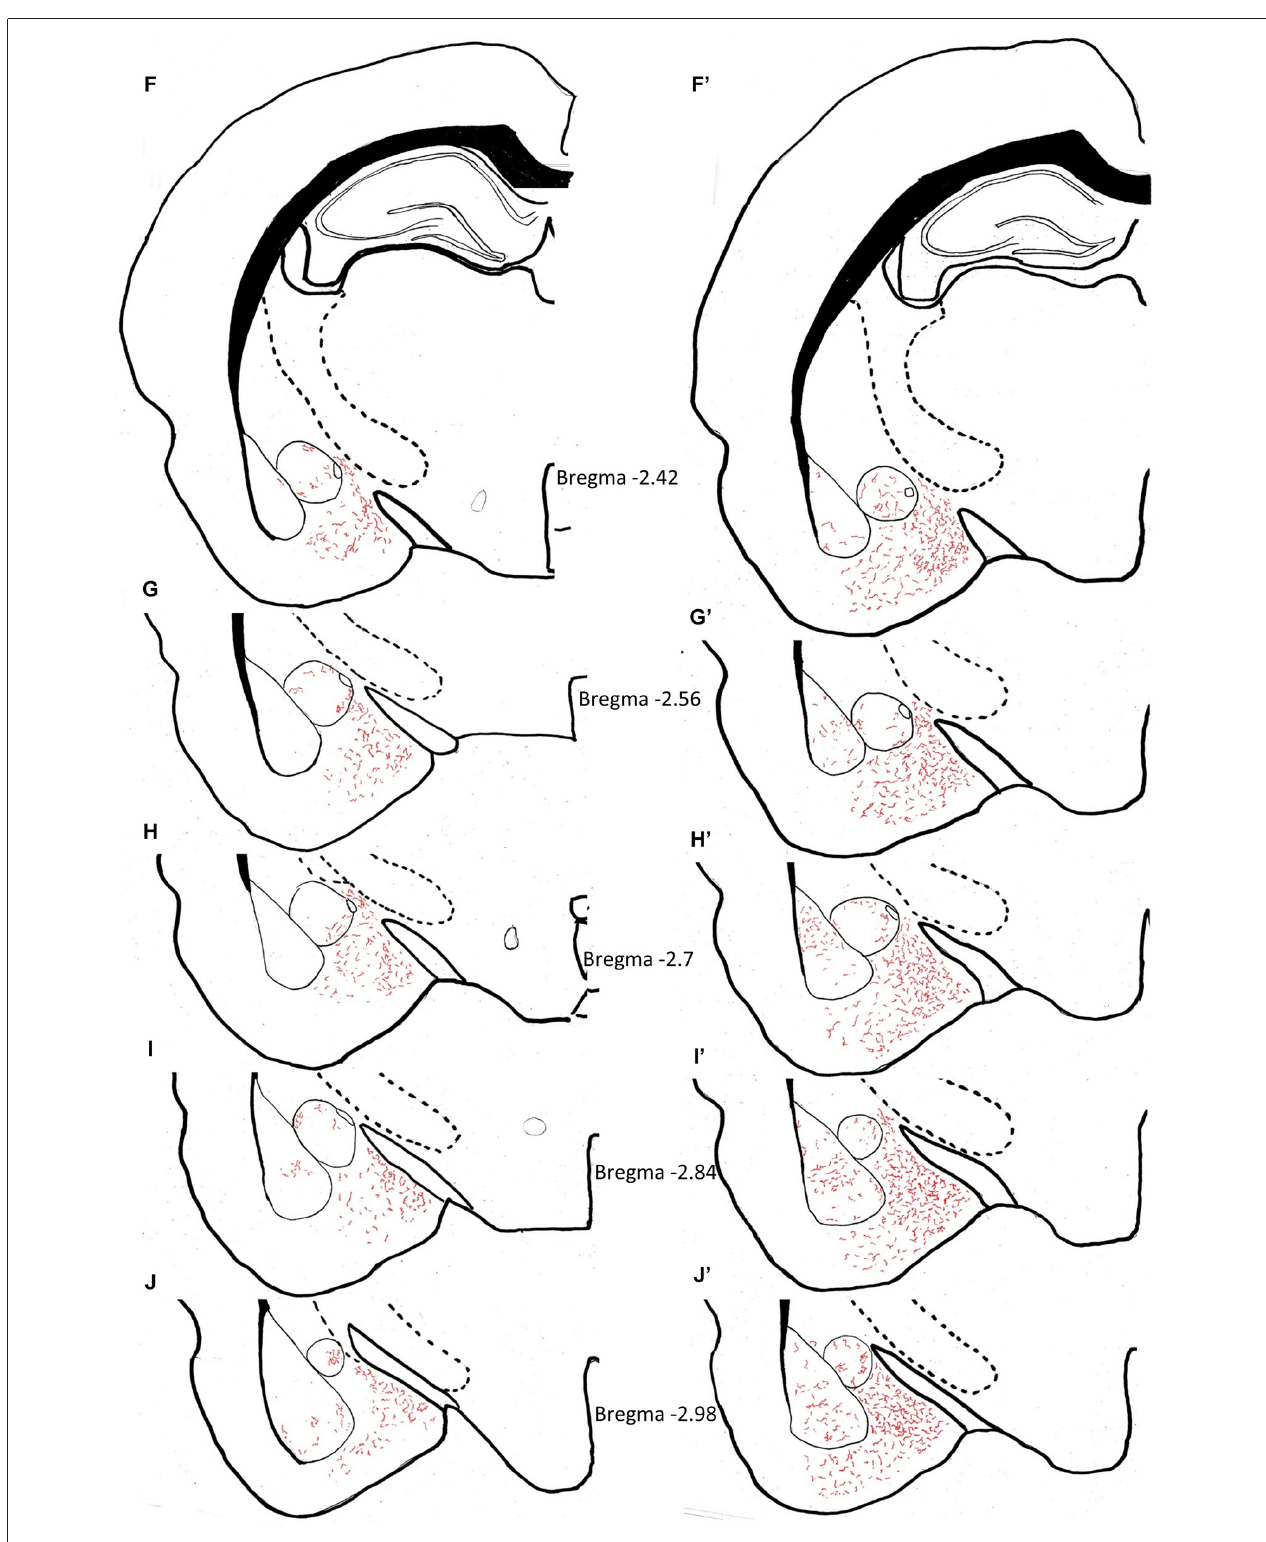
FIGURE 3 | Anatomical charting of AVPir+ fiber distribution in amygdala in both control (A–J) and maternal separation (MS) male adult rat (MS, A’ – J’ ). Chartings of coronal sections at 10 rostro-caudal levels with line drawings referenced with microscopic observation, representing AVP fiber distribution through the entire amygdaloidal complex. Note the remarkable increase in AVP innervation densities in all regions of the amygdala as a function of MS.